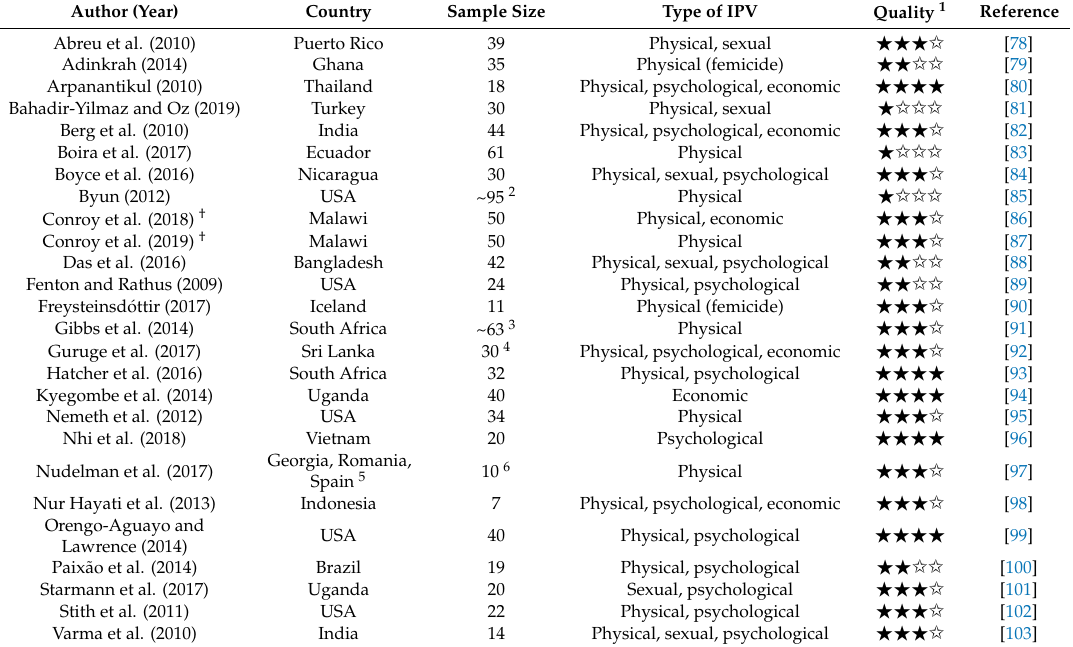
Table 4. Characteristics of included qualitative